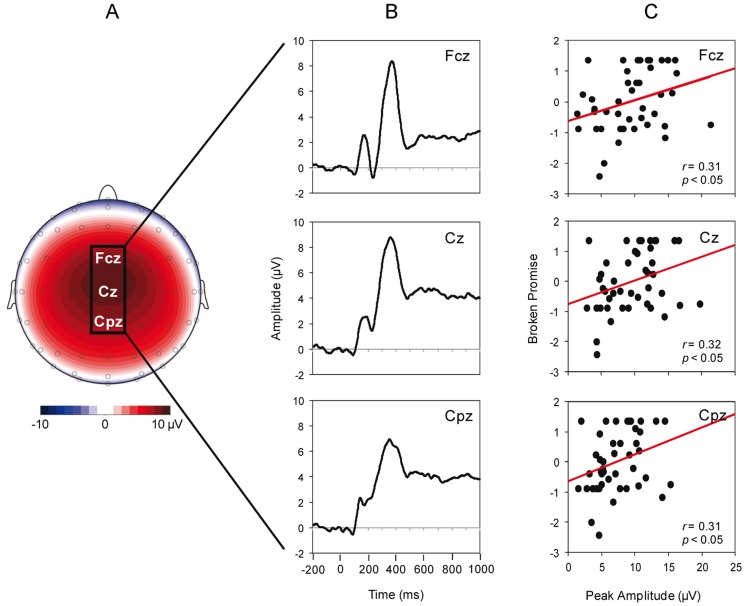
Relationship between the Broken Promise score and the NoGo-P300 amplitudes.A. Approximate scalp position of the electrodes used for the NoGo-P300 peak amplitude, FCz, Cz, CPz. B. Plot of the NoGo-ERPs (stimulus presentation at 0 ms). C. Scatterplots of the correlation between the Broken Promise score (i.e., larger numbers indicate a higher ratio of broken promises) and the NoGo-P300 peak amplitudes.